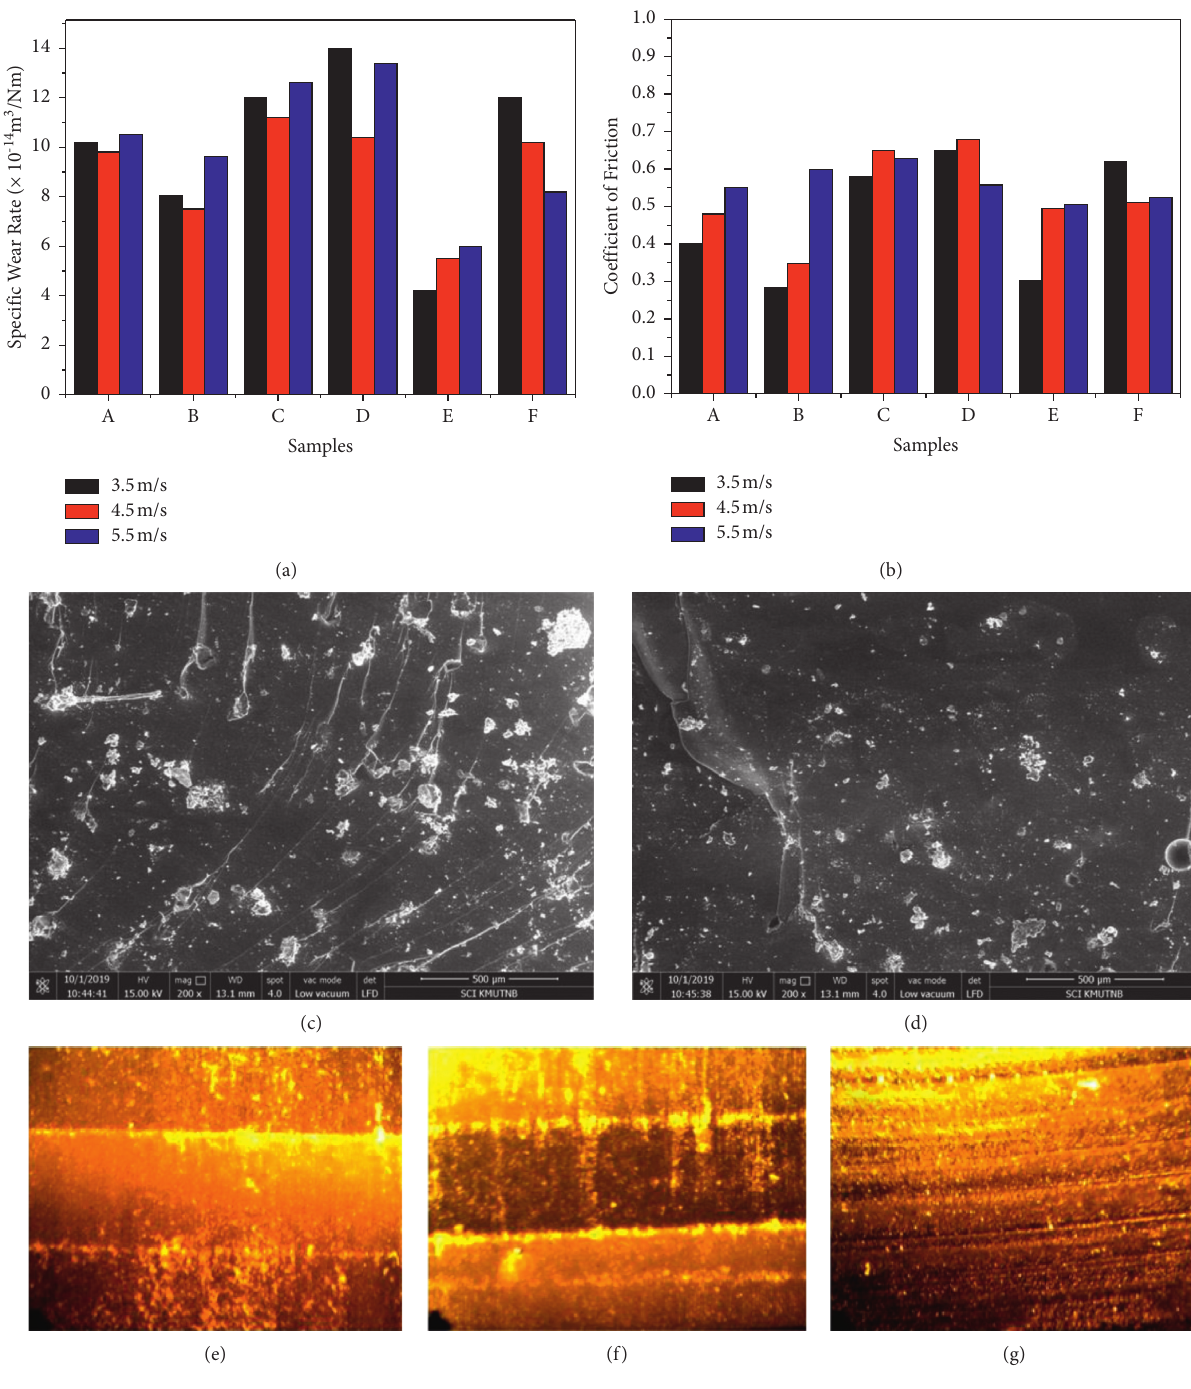
Figure 7: (a) Specific wear rate of the samples. (b) Coefficient of friction of the samples. (c, d) SEM image depicting the wear surfaces. (e–g) Stereo microscope images of the worn surface of the trilayered